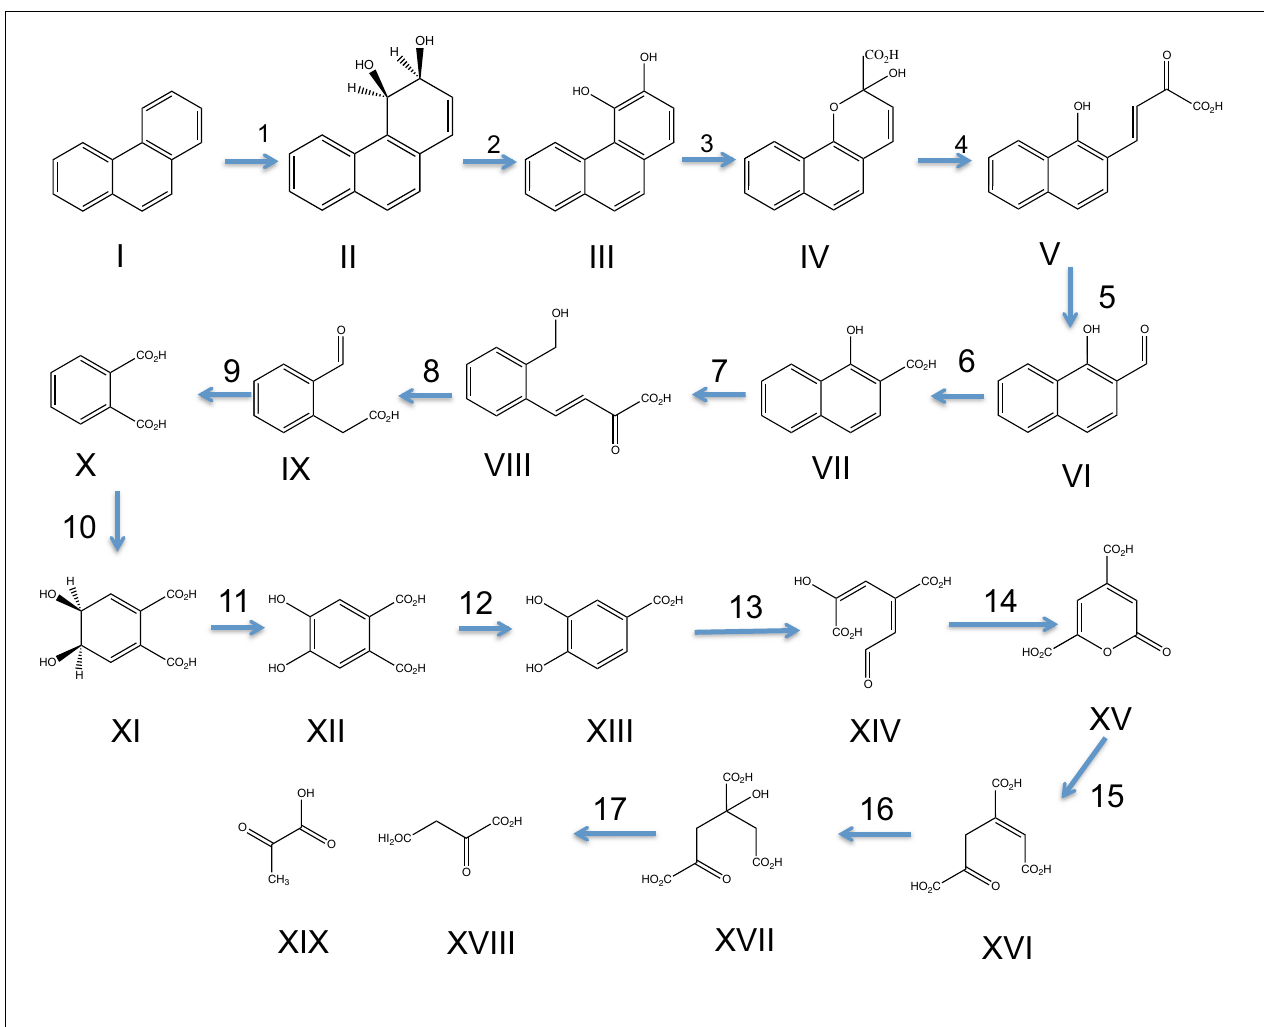
FIGURE 3 | Pathway of phenanthrene degradation through o -phthalate and meta -cleavage of protocatechuate. Compounds are: phenanthrene (I), phenanthrene- cis -3,4-dihydrodiol (II), 3,4-dihydroxyphenanthrene (III), 2-hydroxy-2 H -benzo[ h ]chromene-2-carboxylate (IV), trans